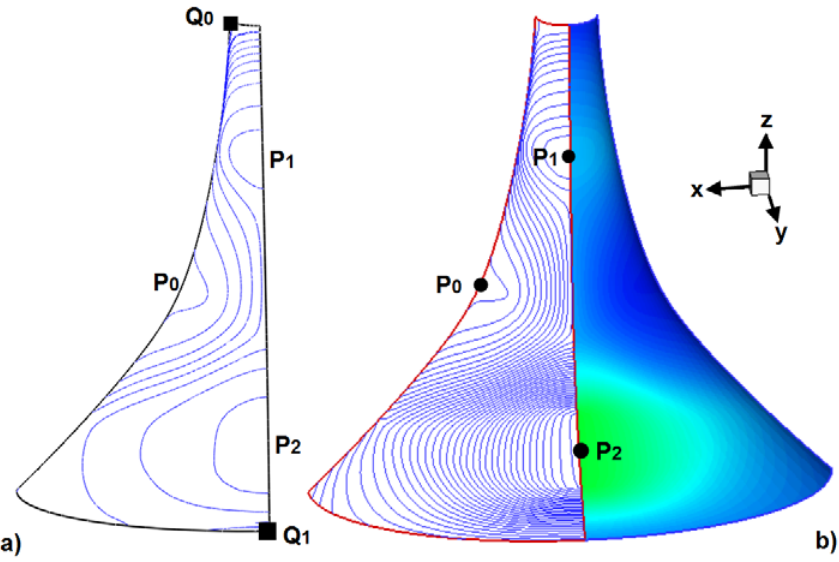
Figure 10. Shell structure analogous to Figure 1: ( a ) Isotherms with a two-node temperature boundary condition at Q 0 and Q 1 ; ( b ) Isotherms with a three-node temperature boundary condition at P 0, P 1 , P 2 , right: Temperature field for extraction of any number of isotherms (fibers).